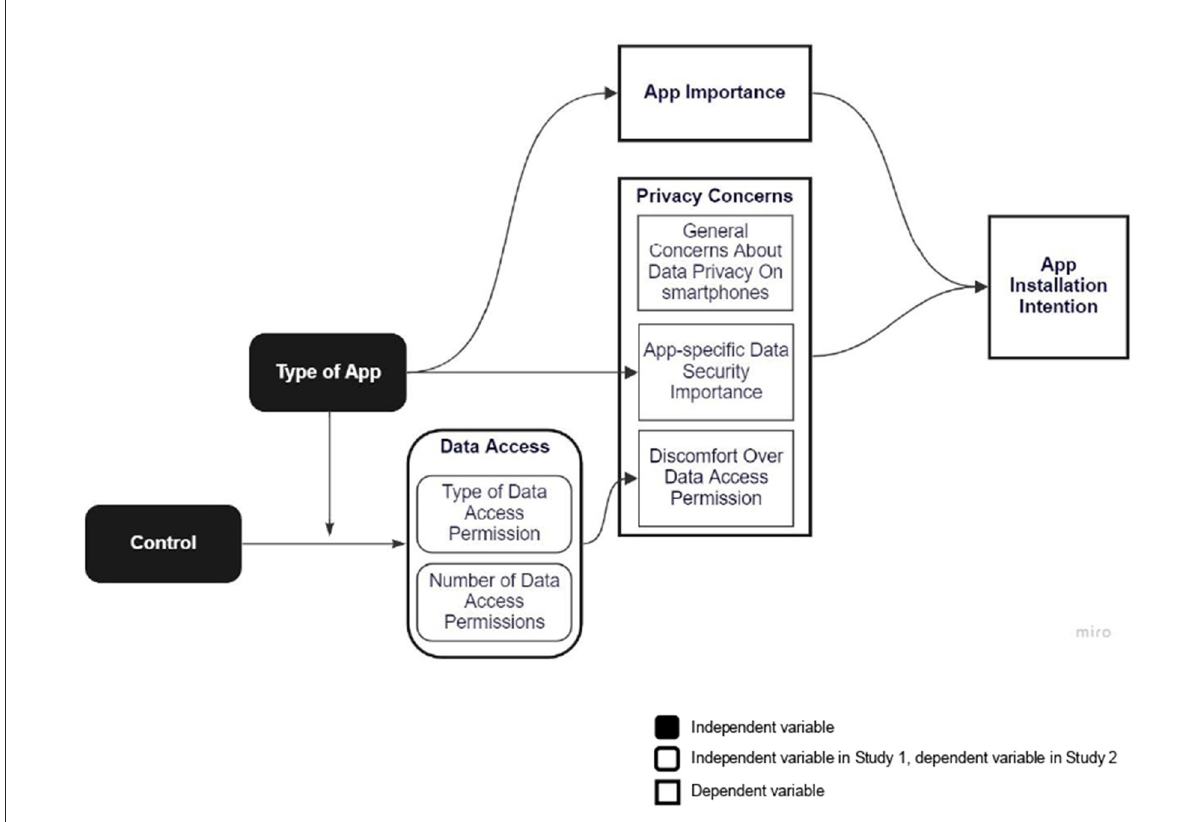
FIGURE4 Diagram of the relationships between the variables as indicated by the results. Privacy concerns dimensions that influenced app installation varied as a function of the type of app and degree of control over data access permissions (see Summary for